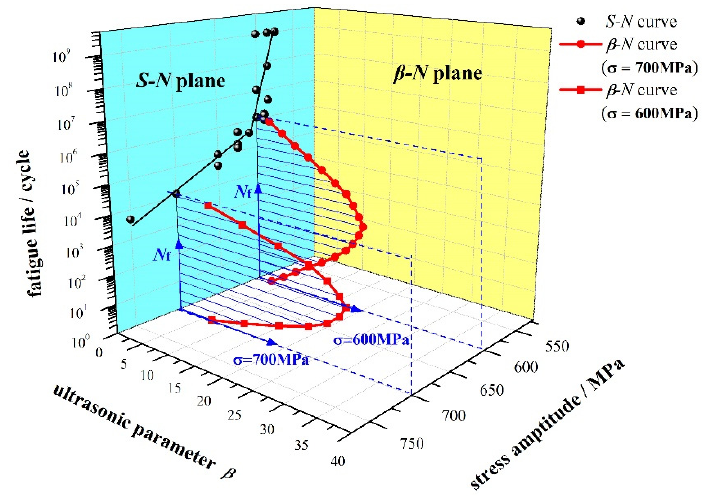
Figure 14. Schematic diagram of the β –S–N three-dimensional model.